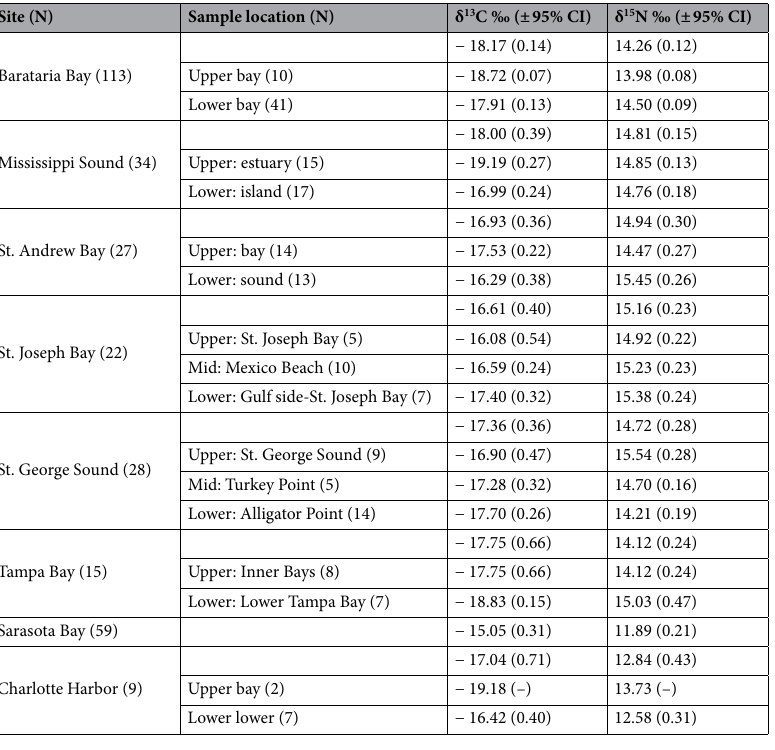
Table 2. Mean δ 13 C and δ 15 N values (± 95% CI) and sample sizes (N = number of dolphins) from each site in the nGoM and sampling locations within each